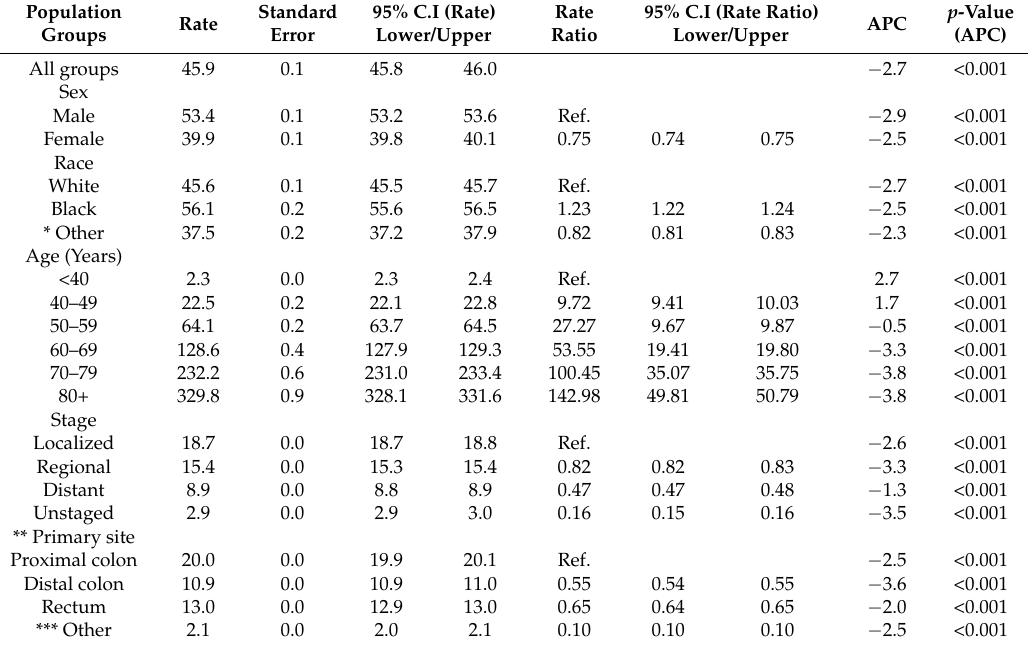
Table 2. Age-adjusted rates of CRC in the US, (18 Surveillance, Epidemiology, and End Results (SEER) Program registries,